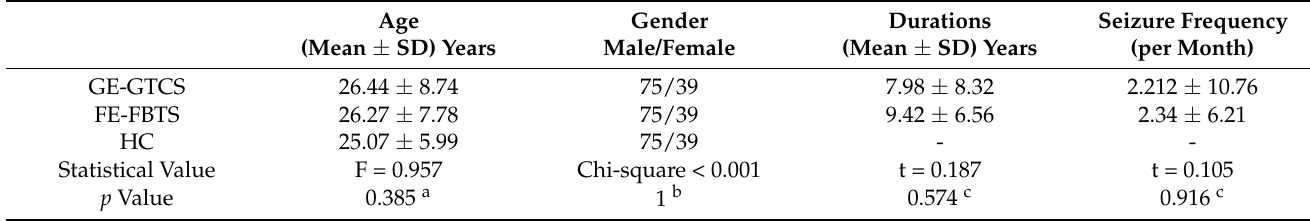
Table 1. Demographic and clinical